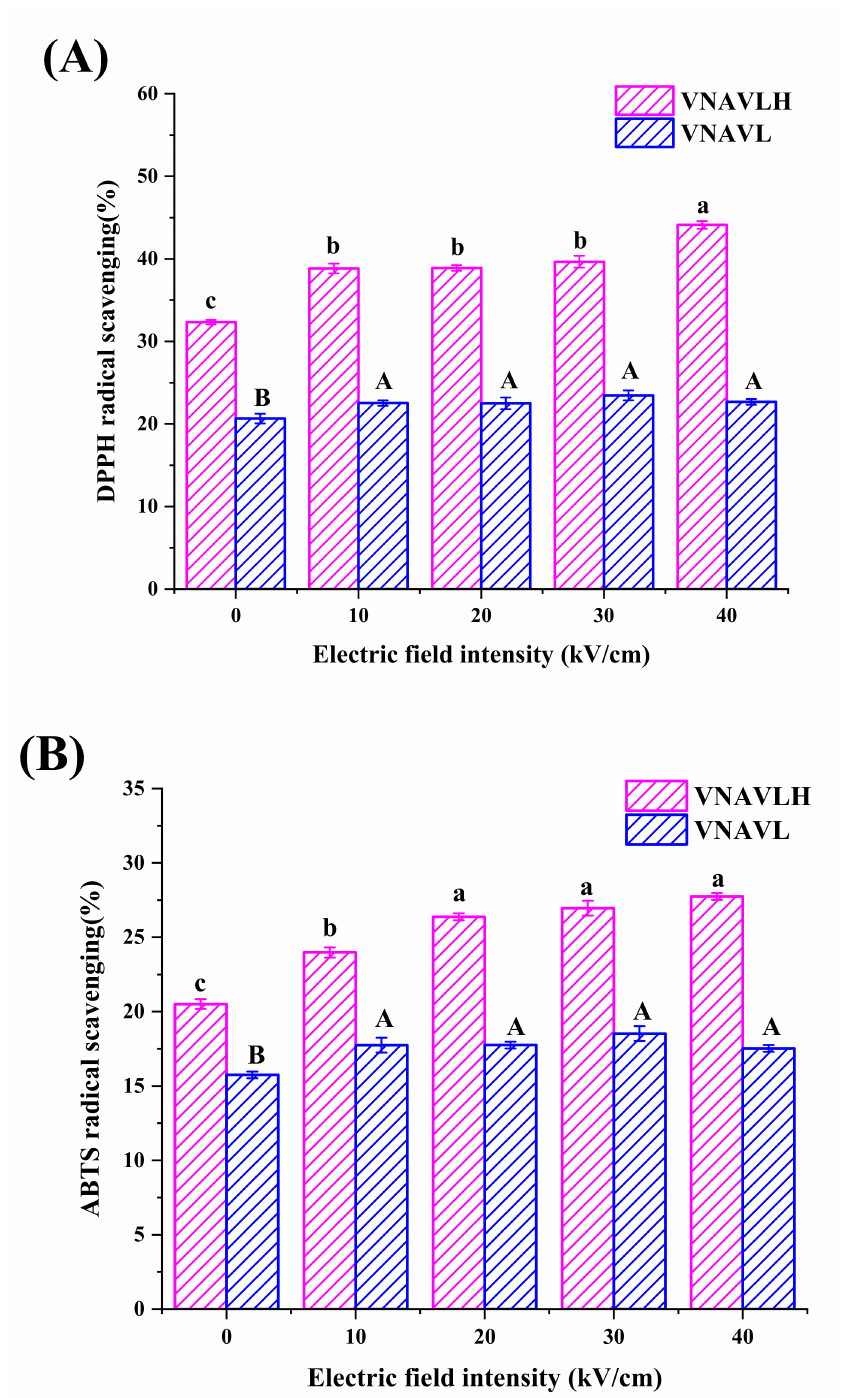
Figure 1. Effects of PEF treatment on ( A ) DPPH and ( B ) ABTS radical scavenging of peptides at different electric field intensities of 10, 20, 30, and 40 kV/cm, respectively. All data were expressed as mean ± standard deviation ( n = 6). The different lowercase letters represent significant differences between different electric field intensities of VNAVLH ( p < 0.05). The different capital letters represent significant differences between different electric field intensities of VNAVL ( p <